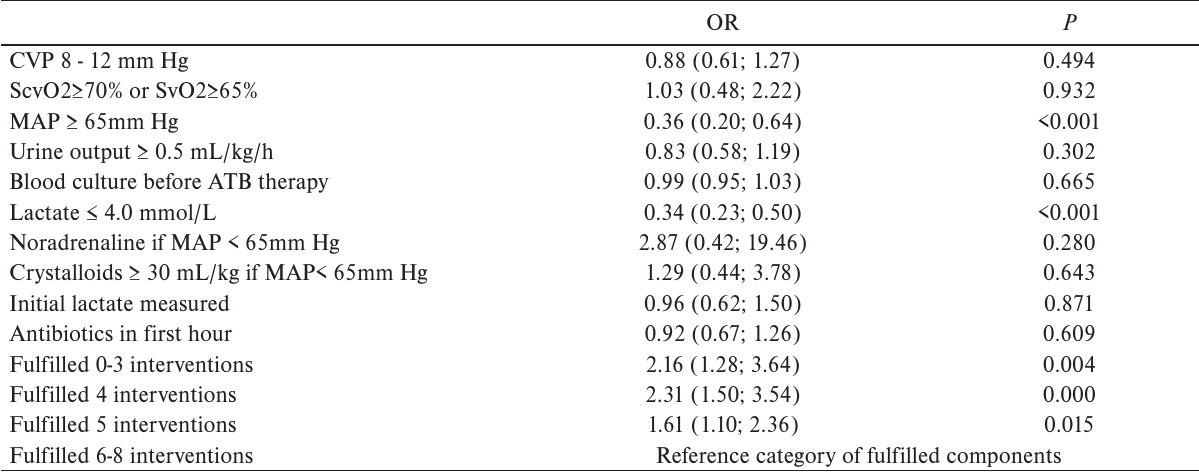
Table 6. Risk of in-hospital mortality adjusted to age and APACHE II.